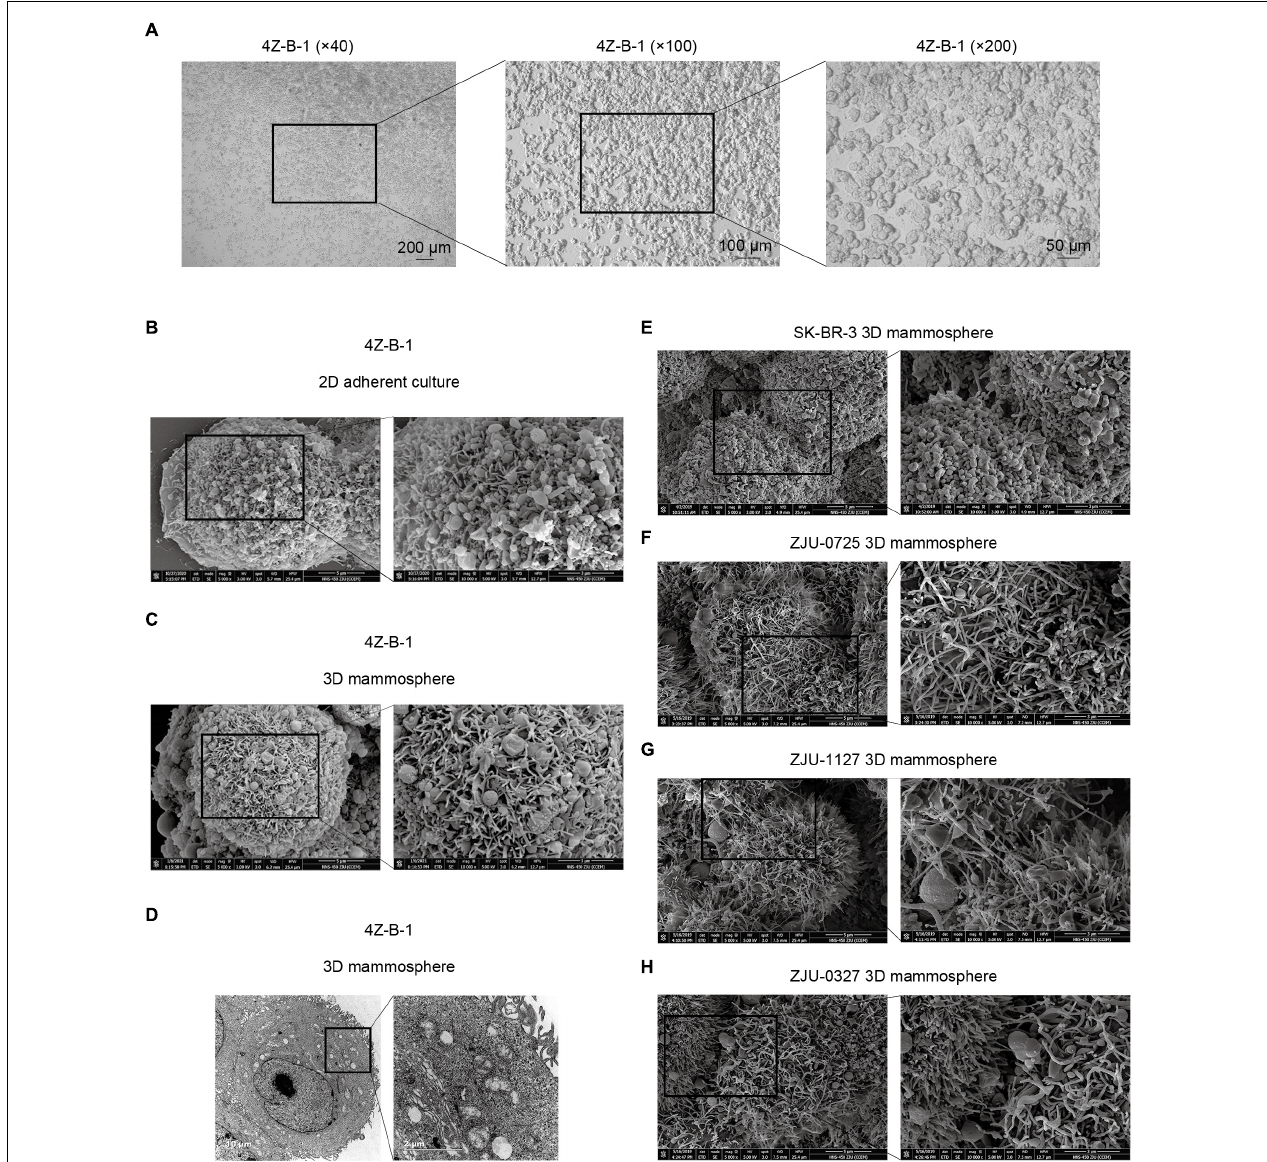
FIGURE 1 | Morphological analysis of the 4Z-B-1 cell line. (A) 4Z-B-1 cells were round and piled up when grown at high density. (B,C) Projections of both spherical and finger-like extensions could be observed on the surface of both 2D adherently cultured 4Z-B-1 cells and 3D 4Z-B-1 mammospheres under scanning electron microscopy (SEM). (D) Nuclei and abundant organelles could be observed under TEM. (E) The projections on the surface of SK-BR-3 cells were almost spherical. (F–H) The projections on the surface of ZJU-0725, ZJU-1127, and ZJU-0327 cells were mostly finger-like. Magnification, (A) left, × 40; middle, × 100; right, × 200; (B,C,E–H) : left, × 5000; right, × 10000; (D) left, × 4800; right, ×